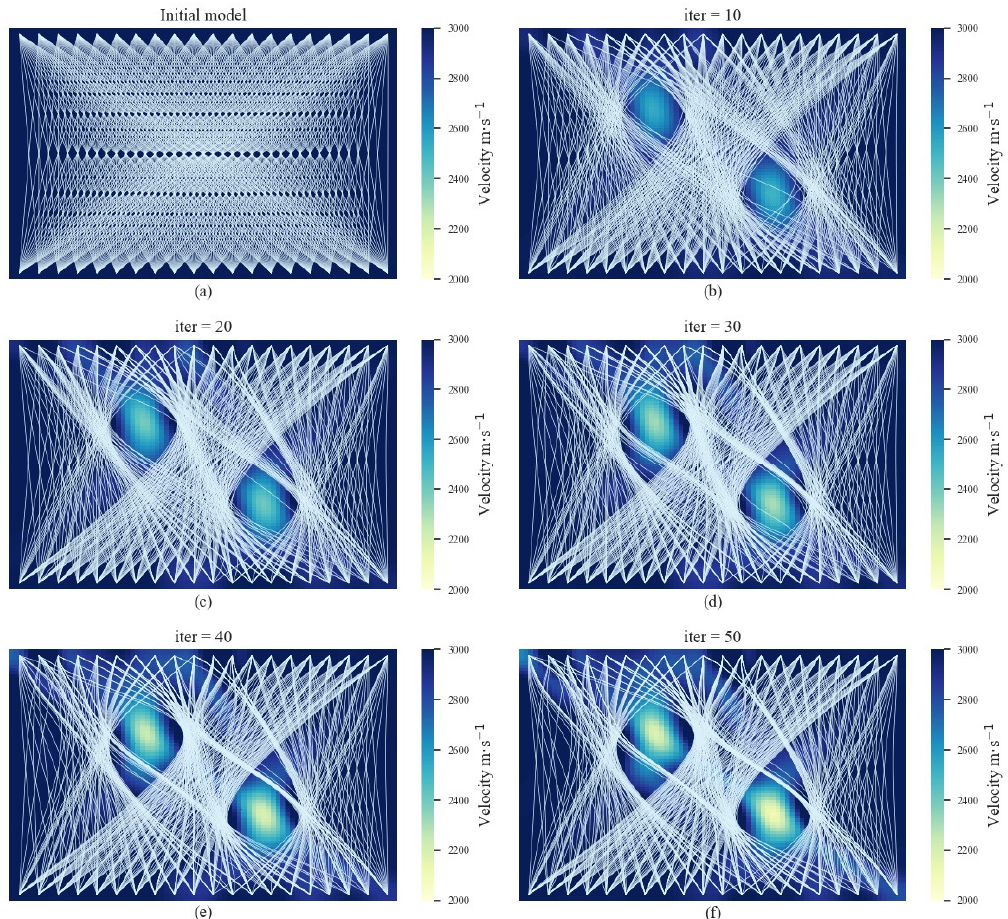
Figure 5. The iteration results of AE tomography in the numerical experiments for multiple cavity damage sources. ( a – f ) show the iteration results from the initial model to the 50th iteration.